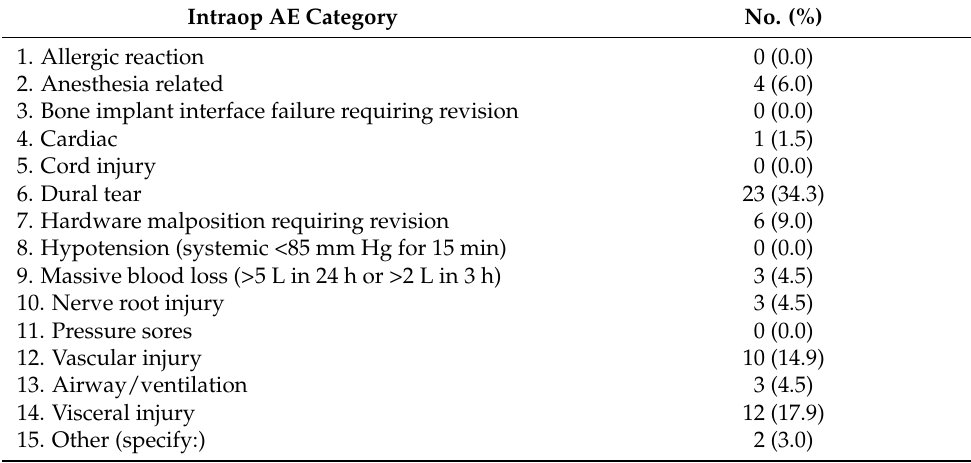
Table 4. Intra-operative